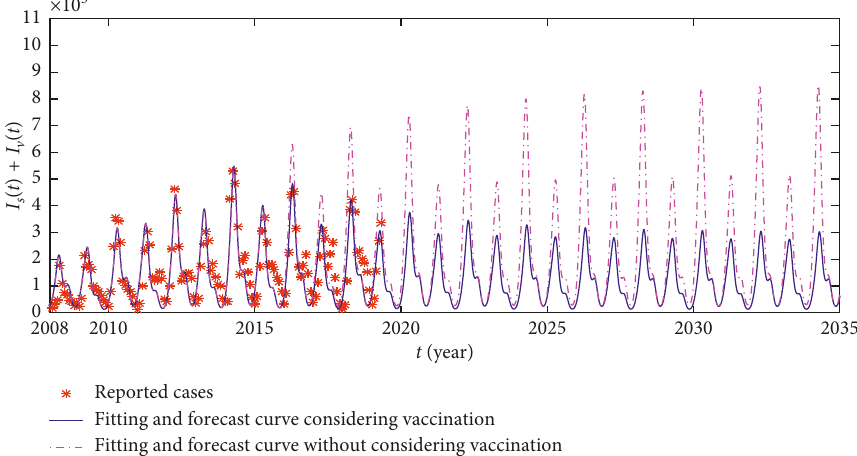
Figure 5: The tendency of HFMD from system (1) with vaccination ( p � 0 before 2016 and p � 0 . 23 in others) and without vaccination in a long time ( p � 0 in all times). The values of other parameters and the initial conditions are the same as in Figure 3.